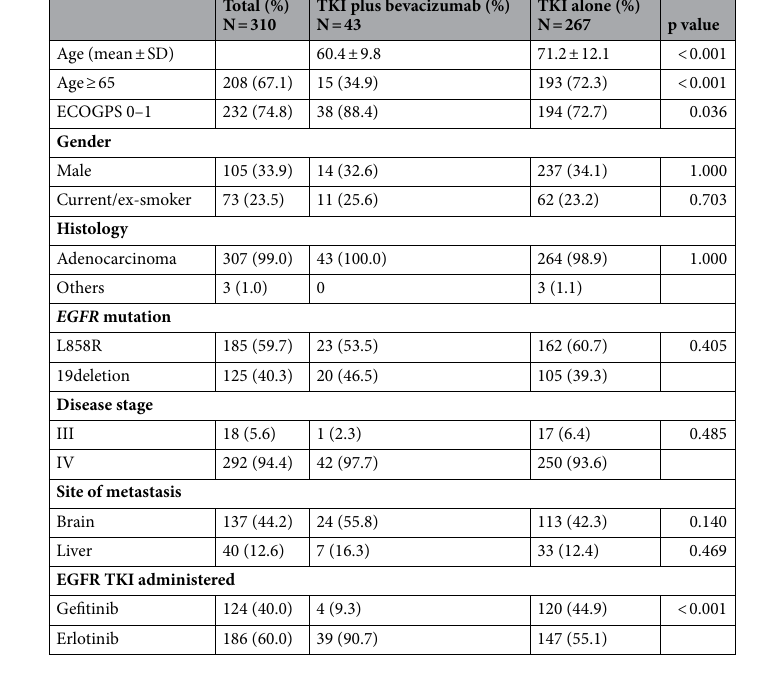
Table 1. Overall patient characteristics.